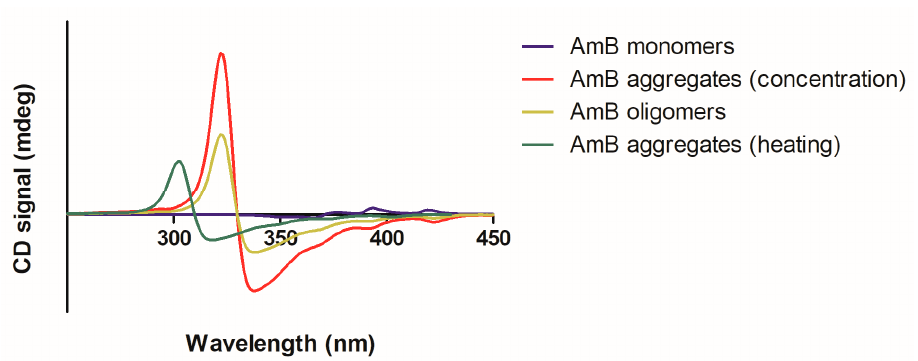
Figure 3. Representative CD spectra of the different AmB supramolecular forms: monomer (in blue); oligomers (moss green); aggregates formed through temperature increase (in green) or concentration increase (in red).